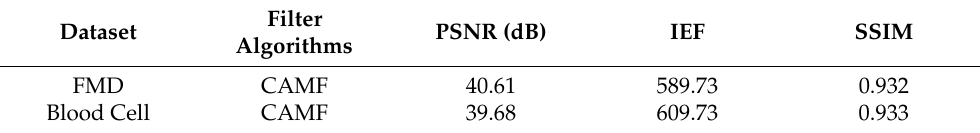
Table 3. Evaluation results based on three error metrics: PSNR, IEF, and